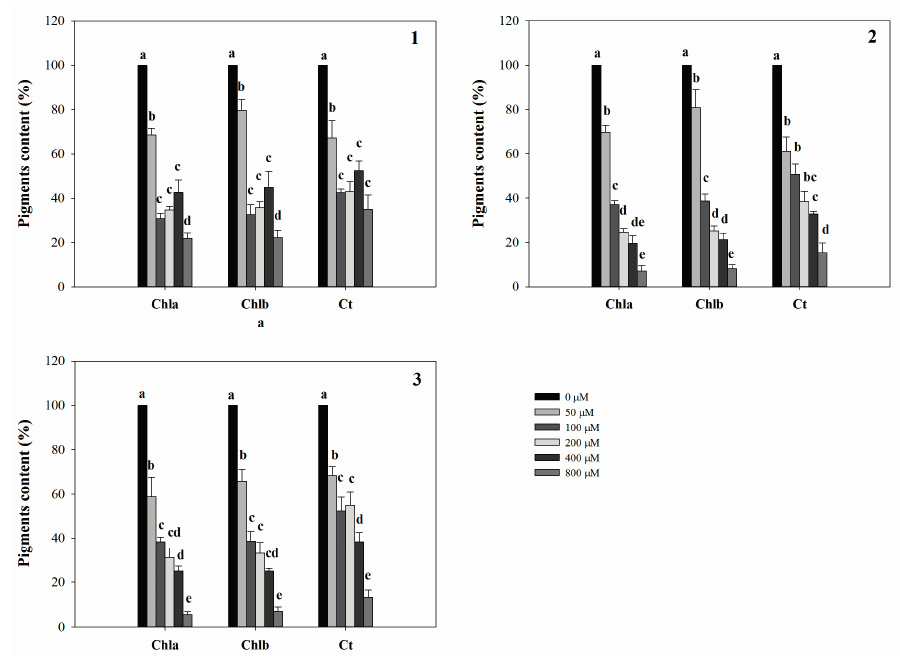
Figure 3. Pigments content in A. thaliana shoots treated with synthetic coumarins 1 – 3 . Data are expressed as percentage of the control. Different letters (a–e) along the bars indicate significant differences at p ≤ 0.05). Homoscedastic data were analyzed by ANOVA with Tukey’s test, whereas the heteroscedastic ones were analyzed with Tamhane’s T2. N =